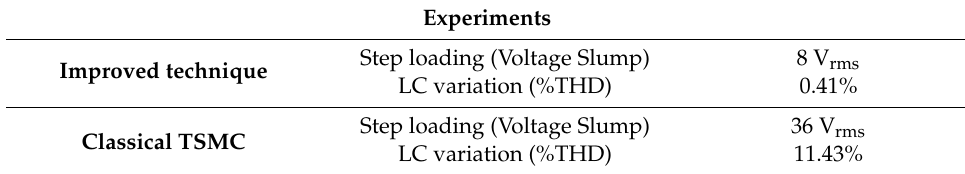
Table 2. Experimental output-voltage slump and %THD under step loading and LC ms/div).